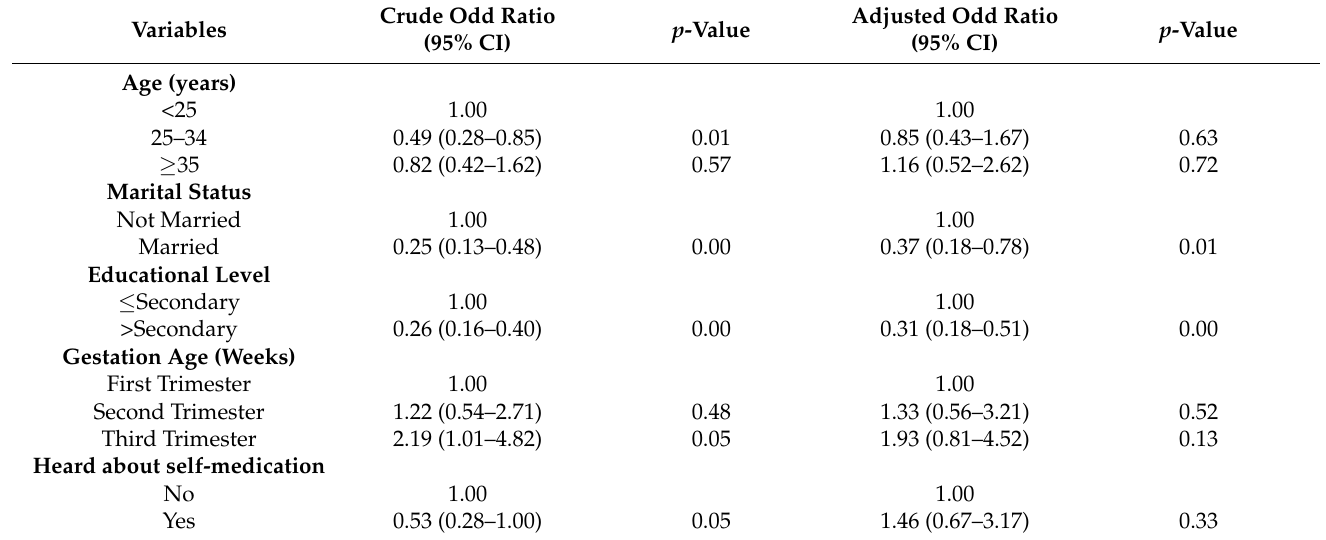
Table 2. Factors associated with self-medication among pregnant